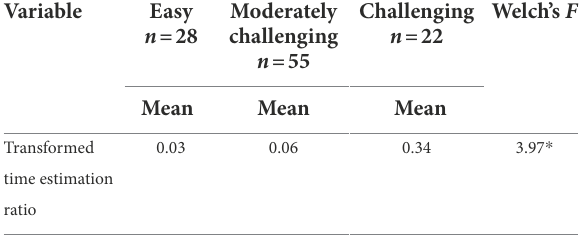
TABLE 4 One-way ANOVA comparing transformed time estimation ratios based on reported anticipated difficulty.